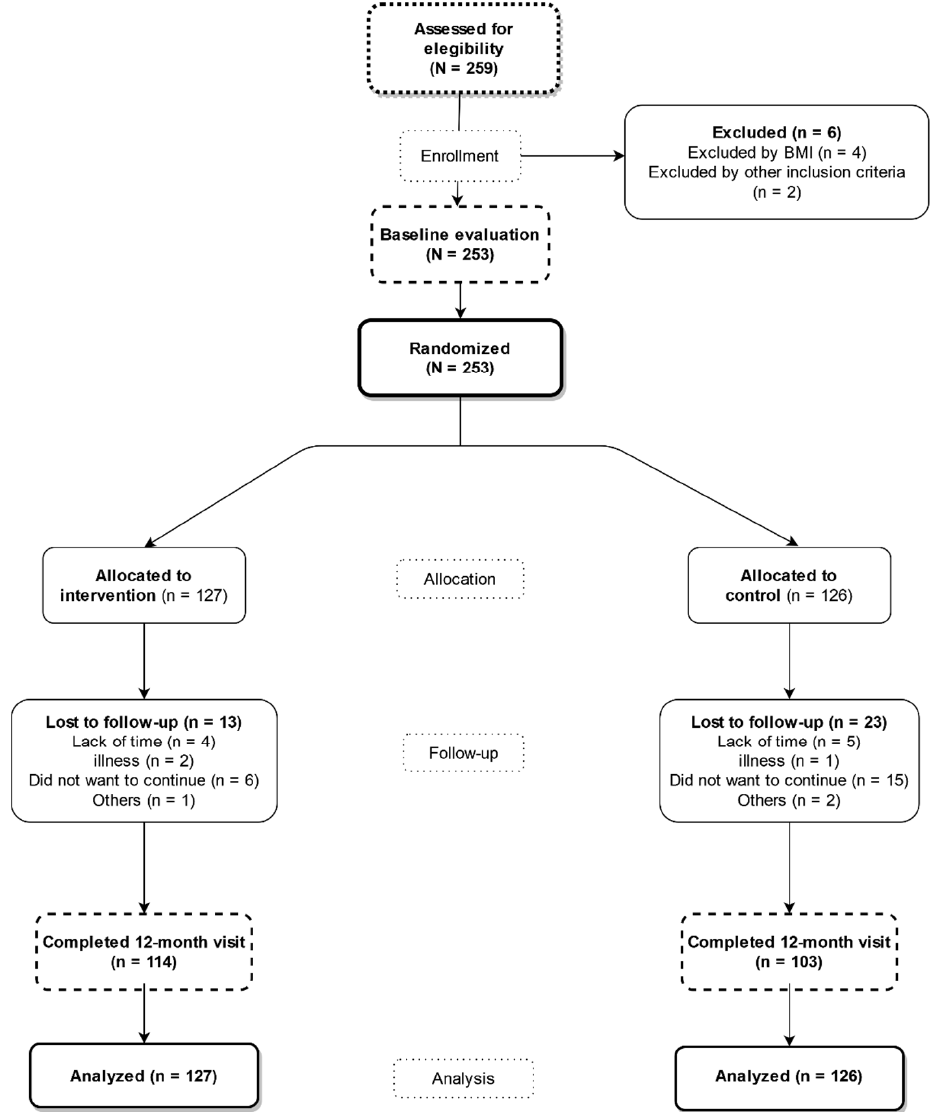
Figure 1. Study flowchart: recruitment of the subjects and completion of the study.